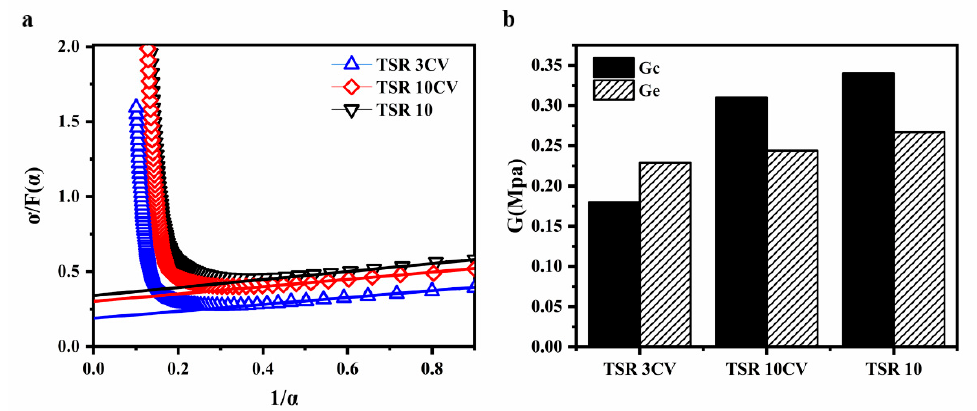
Figure 4. ( a ) Mooney-Rivlin curve of the revised sample; ( b ) G c and G e values of the sample. Table 4. Rubber network structure